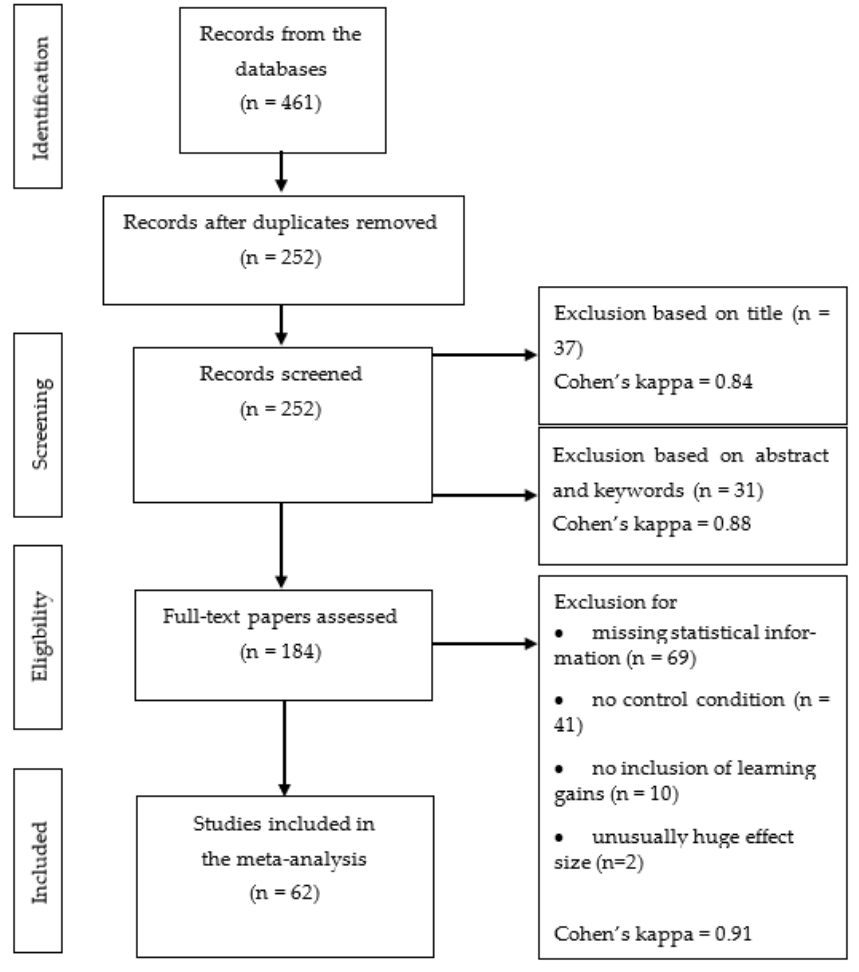
Figure 1. PRISMA flowchart of the study selection process.